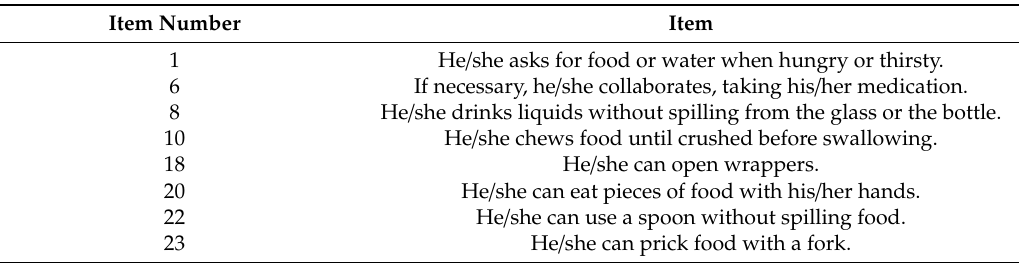
Table 6. Deleted items from the Eating scale.